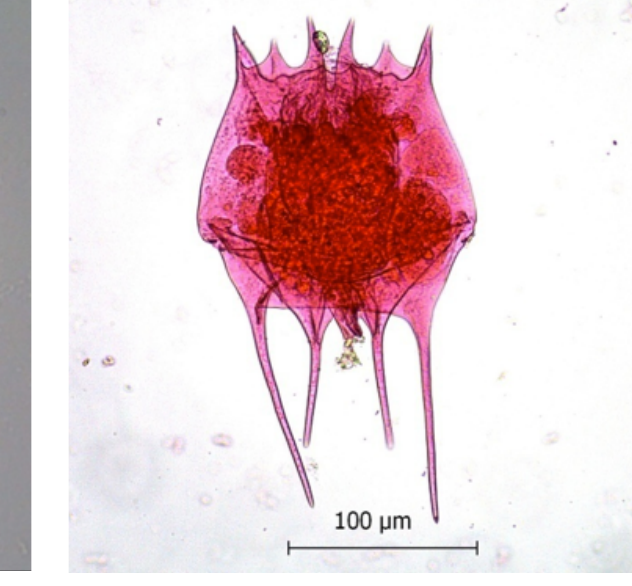
Image 1. Lecane blachei Berzins, dorsal view